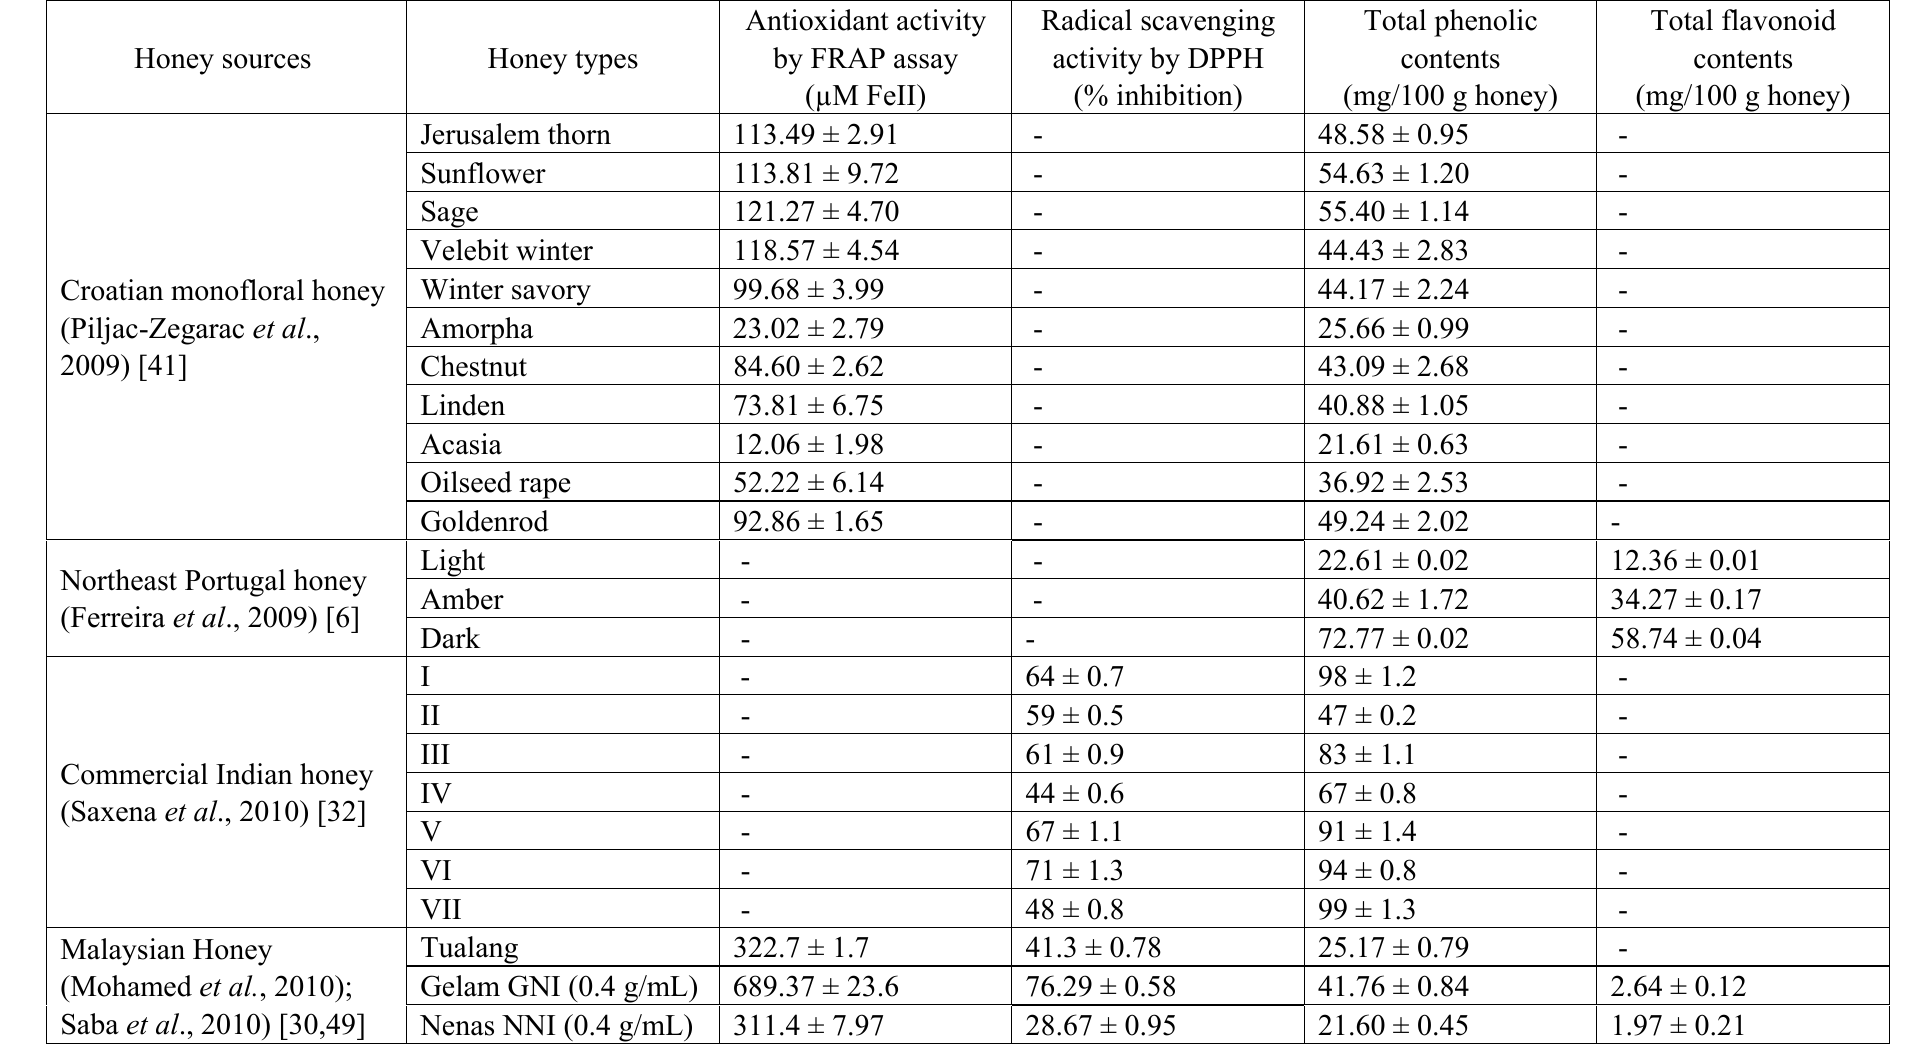
Table 5. Antioxidant properties and total phenolic and flavonoid contents for different types of honey reported by some researchers for comparison with Malaysian